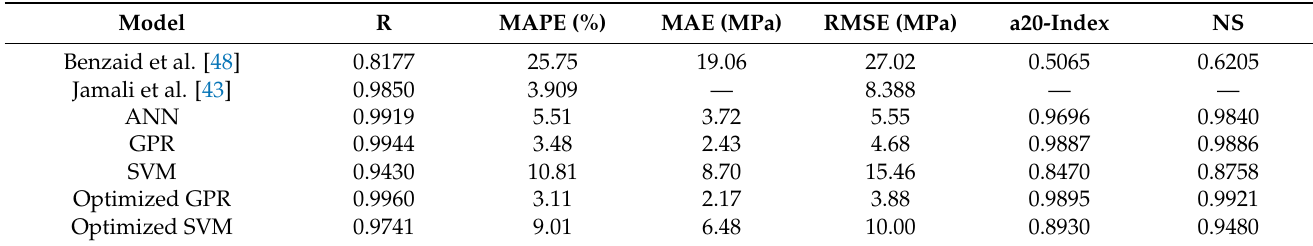
Table 6. Comparison of the best-predicted analytical model with ML models on the basis of statisti- cal parameters.